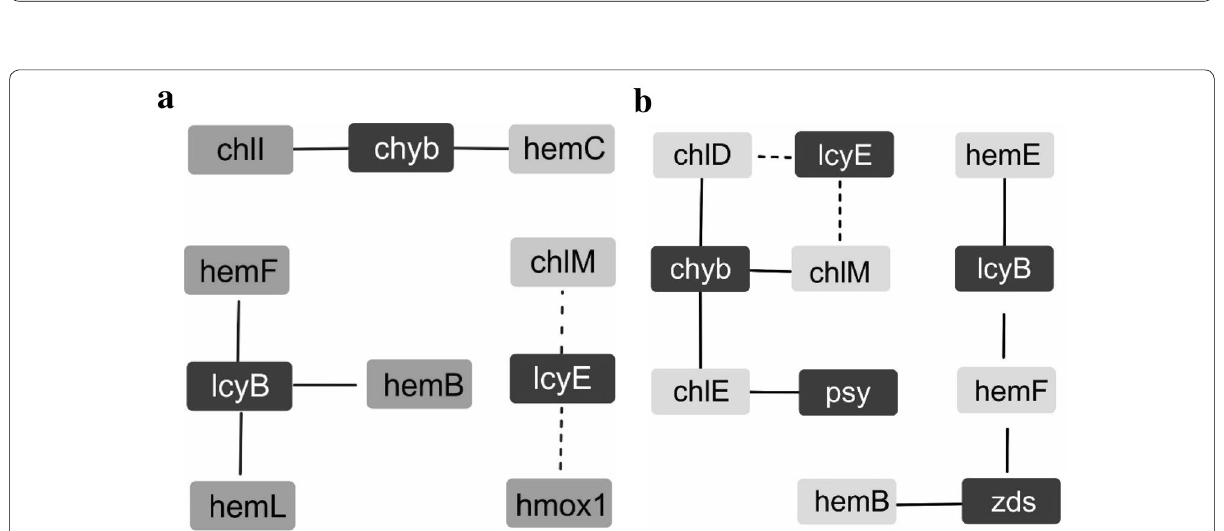
Fig. 3 The co-transcription network of carotenoid and chlorophyll genes. a 1235 SHDP route; b 1246 SHDP route. Dark gray and light gray represent carotenoid synthesis genes and chlorophyll synthesis genes, respectively. The solid line and the dotted line represent a negative correlation and a positive correlation between astaxanthin metabolism and chlorophyll metabolism, respectively. The number of replications is two ( n